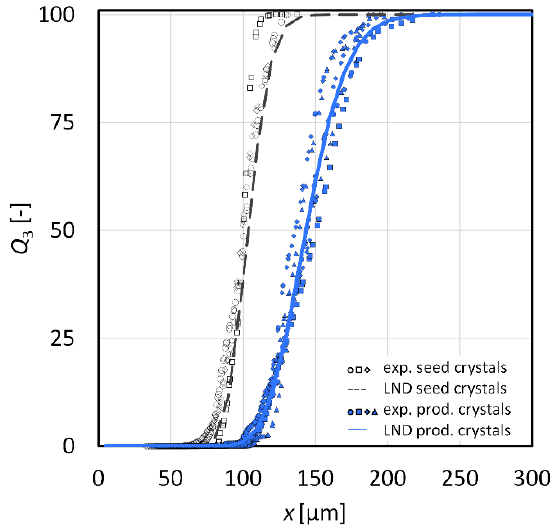
Figure 7. Crystal size distribution (sedimentation method) with logarithmic normal size distribution (LND) for seed and product crystals for crystal growth experiments with glycine/water.